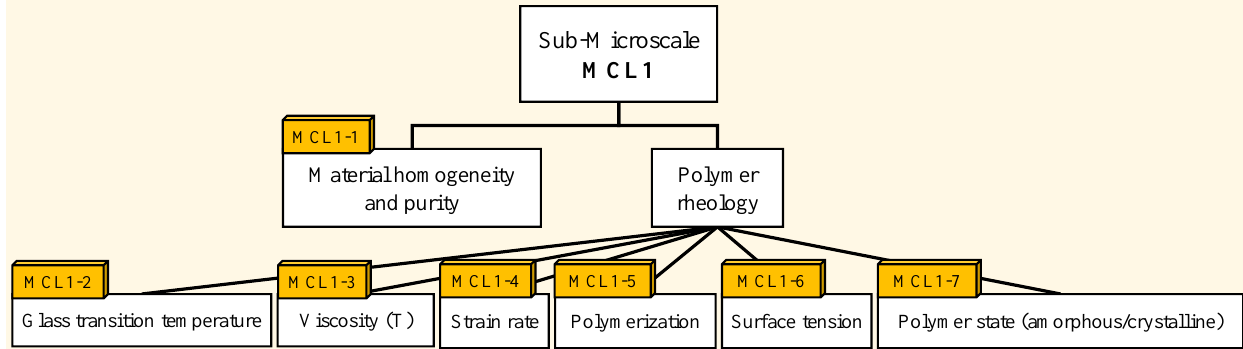
Figure 7. Essential manufacturing constraints at the sub-microscale level.